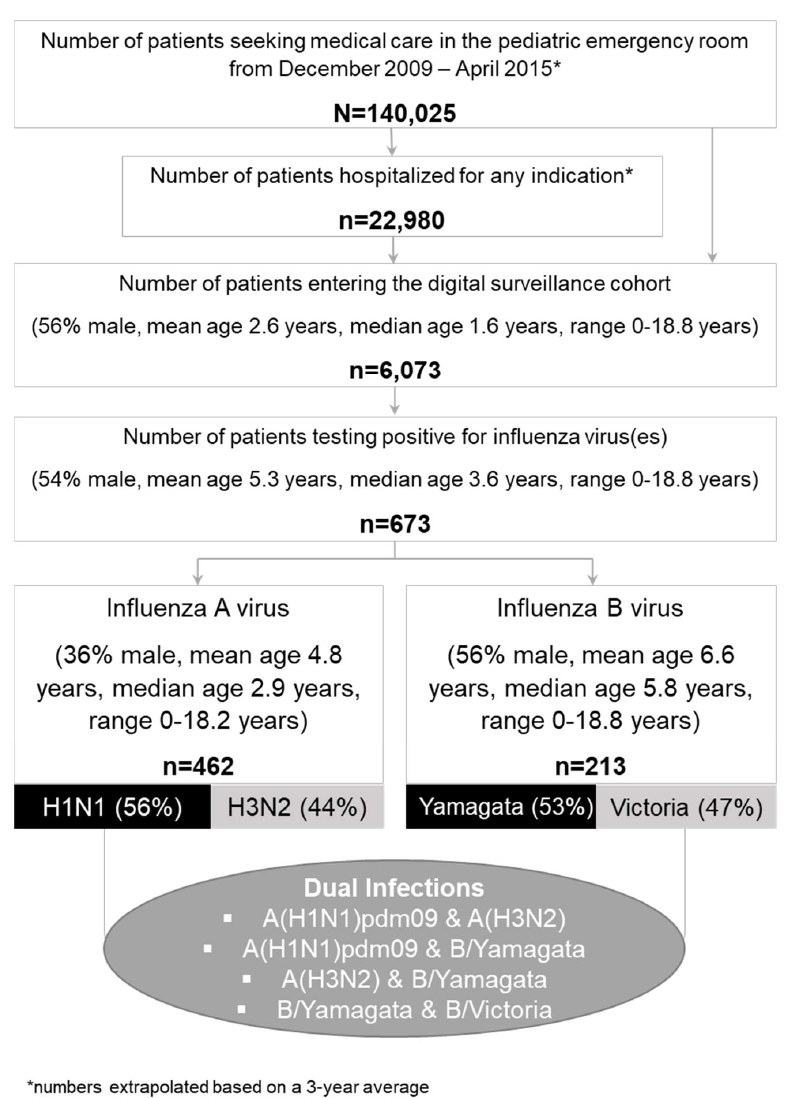
between October and April. Yet, IBV was almost absent that year. Figure 2 depicts num- bers of IAV/IBV-positive cases, including subtypes and lineages per season. Overall, four patients out of 6073 (0.07%) presented with IV A/A, A/B, or B/B dual infections. This corresponds to an incidence rate of 12/100,000 ILI patients ( per annum , as observed in an observation period of 65 months total).